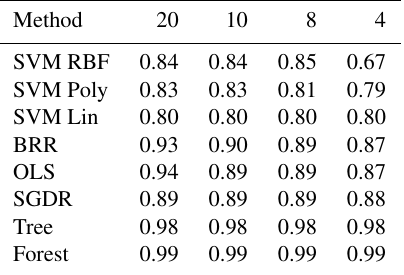
Table 3. Median cosine angle between measured and predicted spectra, applying PCA analysis to the “combined” fingerprints, as a function of the number of principal components used given above each column. The method labels are as follows: SMV (support vec- tor machine with three kernels (RBF, Poly(nomial) and Lin(near))); BRR: Bayesian ridge; OLS: ordinary least squares; SGDR: stochas- tic gradient descent; Tree: decision tree; and Forest: random forest.